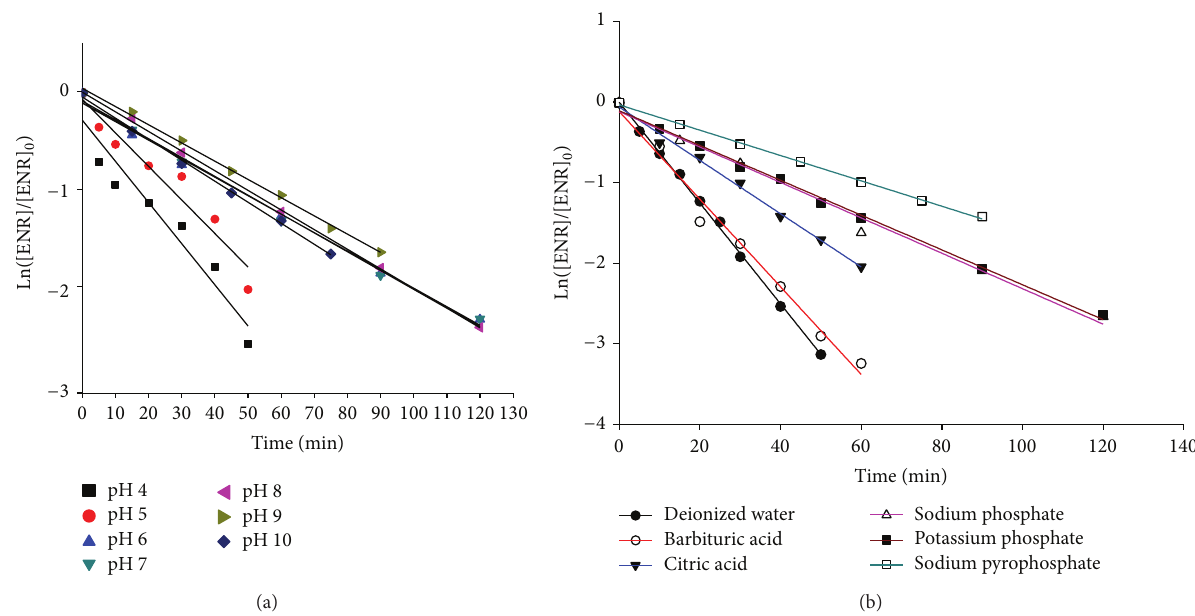
Figure 1: The time course of ENR (10 𝜇 M) oxidation with Mn(VII) (500 𝜇 M) at pH 4.0–10.0, acetate buffer for pH 4-5, phosphate buffer for pH 6–8, borate buffer for pH 9-10 (a); the time course of ENR (10 𝜇 M) oxidation with Mn(VII) (500 𝜇 M) in solutions with different buffers. Experimental condition: [ENR] 0 = 10 𝜇 M, [ KMnO 4 ] 0 = 500 𝜇 M, pH 7.0, and 𝑇 = 21 ∘ C